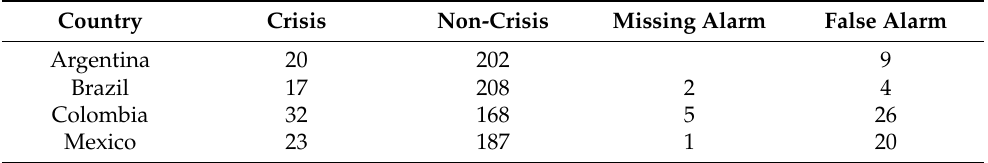
Table 12. Performance of EWS model in Latin American countries, cut-off = 12.02%.